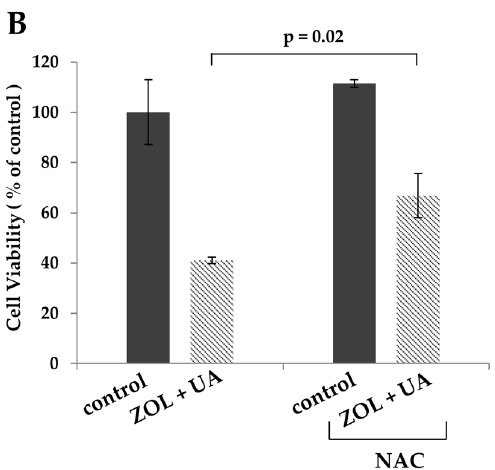
Figure 7. ROS is involved in the apoptosis effect of the UA/ZOL combination. ( A ) ROS inhibitor, N -acetyl- L -cysteine (NAC) decreases the apoptosis induced by the combination of ZOL and UA. U-2 OS cells were treated with ZOL (10 μ M) and UA (20 μ M) in the absence or presence of NAC (2 μ M) for 48 h. The treated cells were stained with Annexin-V and PI to analyze the percentage of apoptosis cells as indicated numbers by flow cytometry; and ( B ) NAC rescues the cell viability inhibition caused by the combination of ZOL and UA determined by MTT assays.